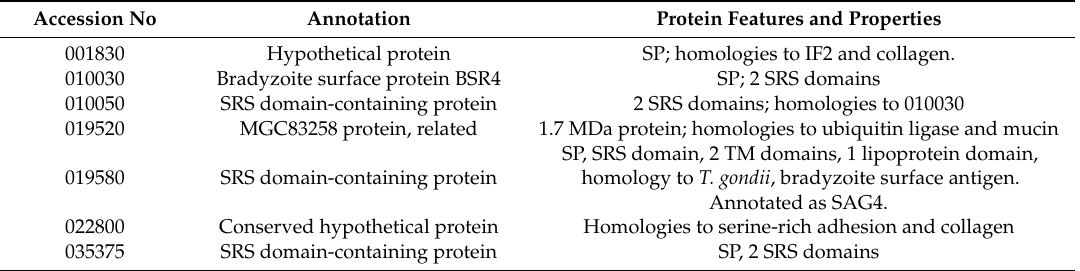
Table 3. List of proteins overexpressed in MNCs formed by BKI-1294 treatment of Neospora